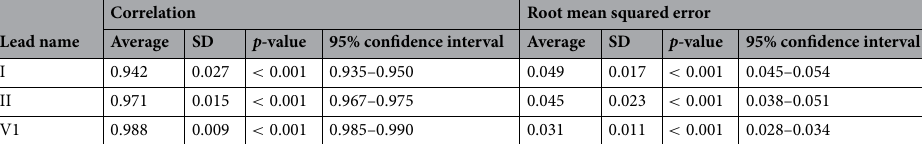
Table 6. Correlation and root mean squared error (RMSE) statistics of the digitised results from selected 51 3 by 1 ECG images and the ground truth digital ECGs (validation 2).